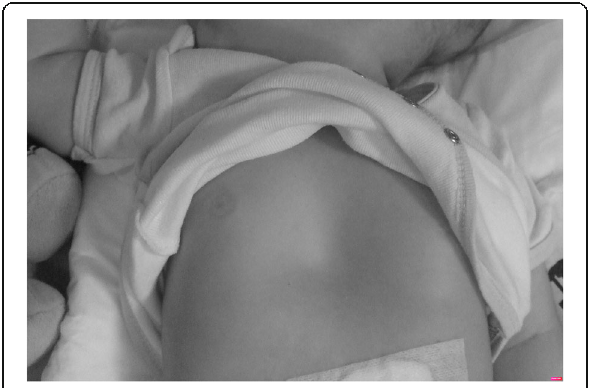
Fig. 4 Pectus excavatum of XLMTM patient